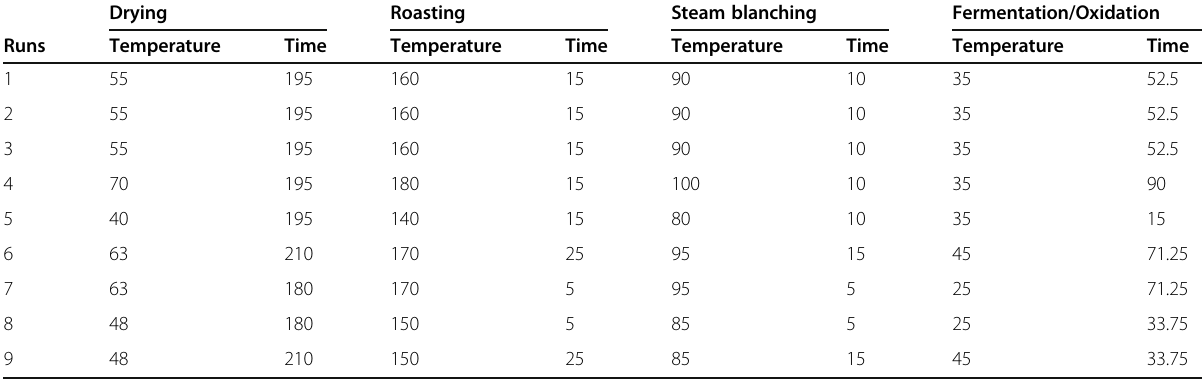
Table 2 Doehlert design showing experimental runs for every post-harvest treatment Drying Roasting Steam blanching Fermentation/Oxidation Runs